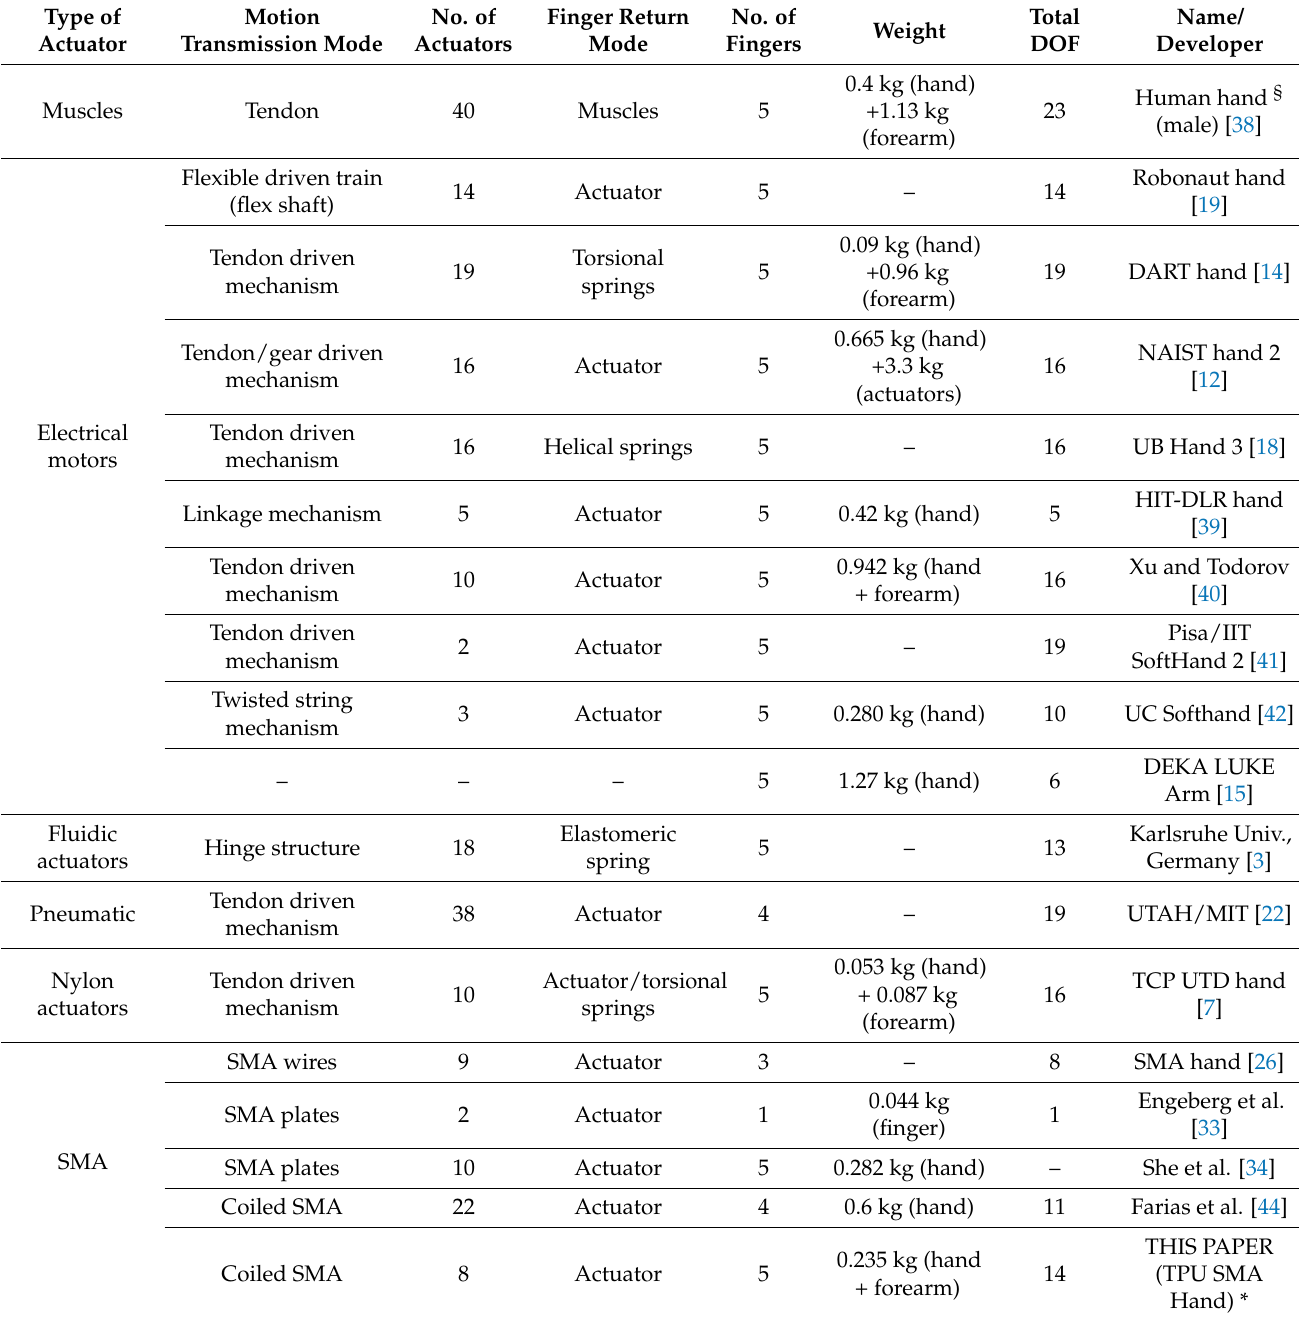
Table 1. Characteristics of existing artificial hands and fingers compared with coiled shape memory alloy (SMA) actuated